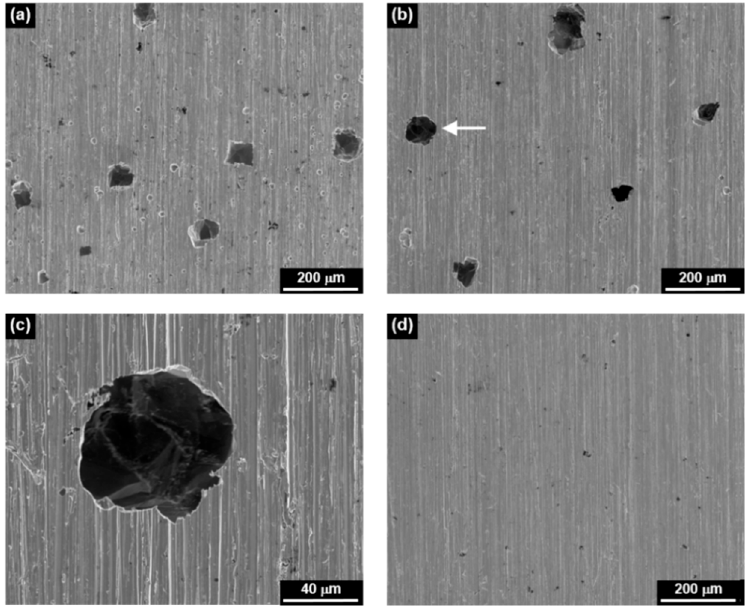
Figure 2. Scanning electron microscopy (SEM) micrographs showing the corroded surfaces of Alloy 600 after polarization scans at ( a ) the MRI 0.1, ( b ) the MRI 1, ( c ) magnification of the pit denoted by the white arrow in (b), and ( d ) the MRI 10.